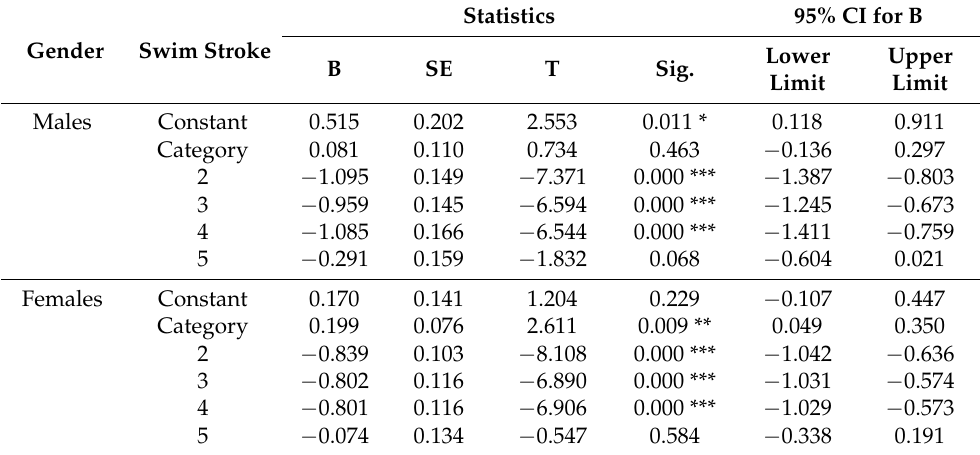
Table 2. Coefficients from linear regression